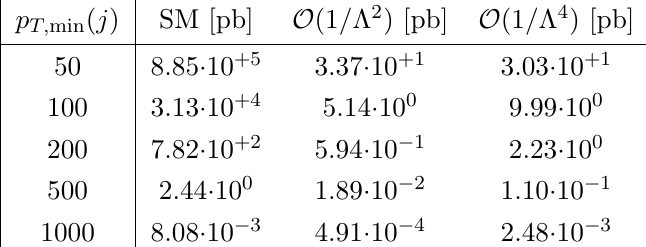
Table 1 . Cross-sections for the production of three partonic hard jets, isolated using di(cid:11)erent values of a p T; min -cut and (cid:1) R = 0 : 4. The scale (cid:3) is set to 5 TeV. In the computation of the result of order O (1 = (cid:3) 4 ), only the contributions from at most one insertion of the operator O G in the amplitudes are considered.